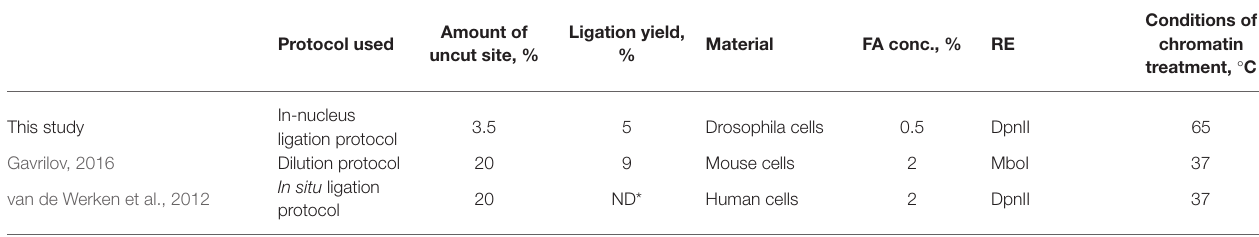
TABLE 3 | Amounts of uncut site and the ligation yield in different type of